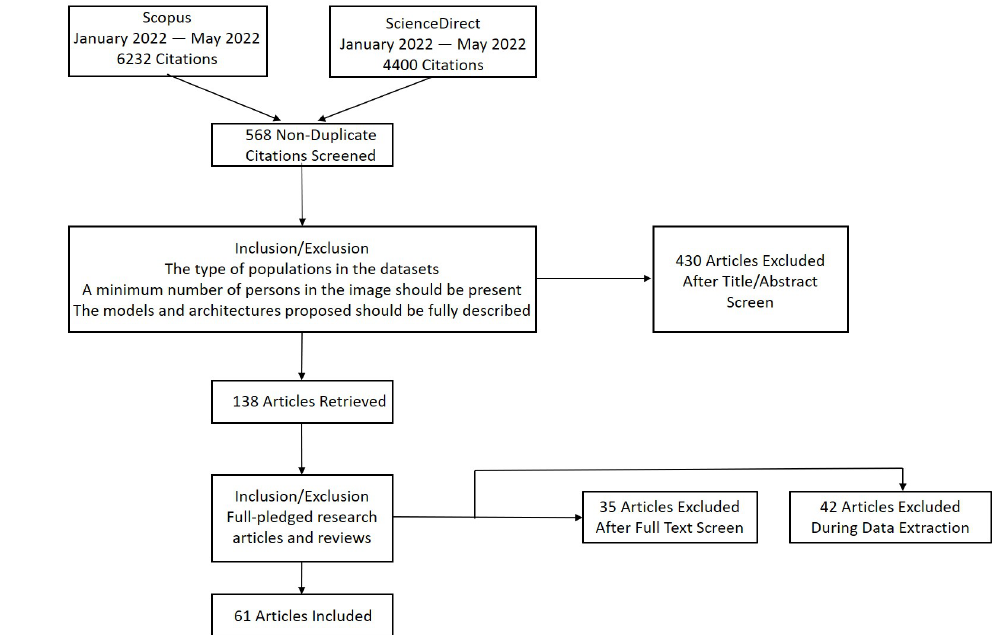
Figure 2. PRISMA diagram showing the results of the executed literature